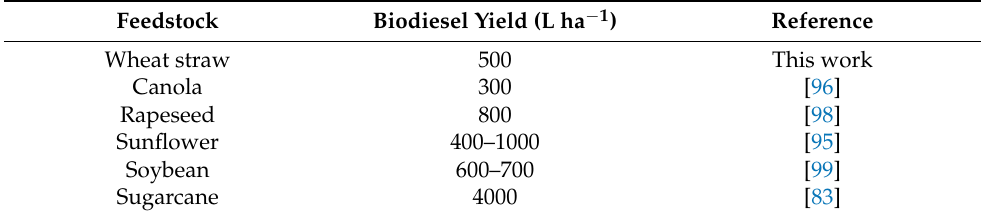
Figure 5. The mass balance of microbial lipid production from wheat straw using the oleaginous yeasts L. tetrasporus DSM 70314. Table 9. Biodiesel yield per hectare from conventional